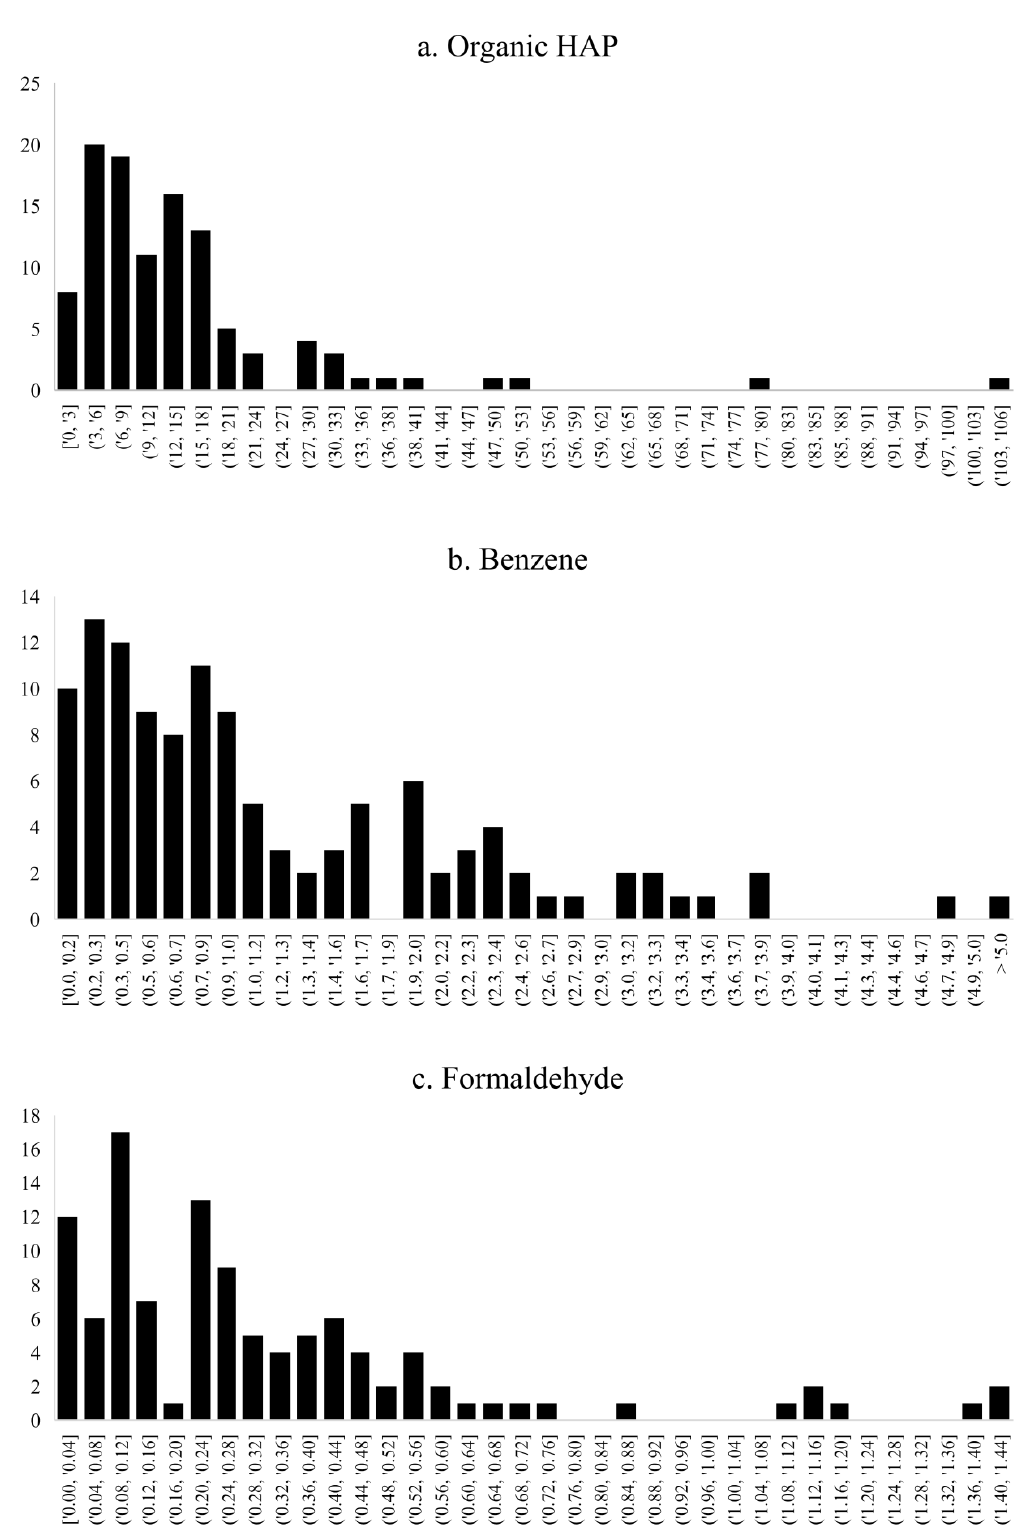
Figure 5. Distribution of the dataset for ( a ) organic HAPs; ( b ) benzene; ( c ) formaldehyde.